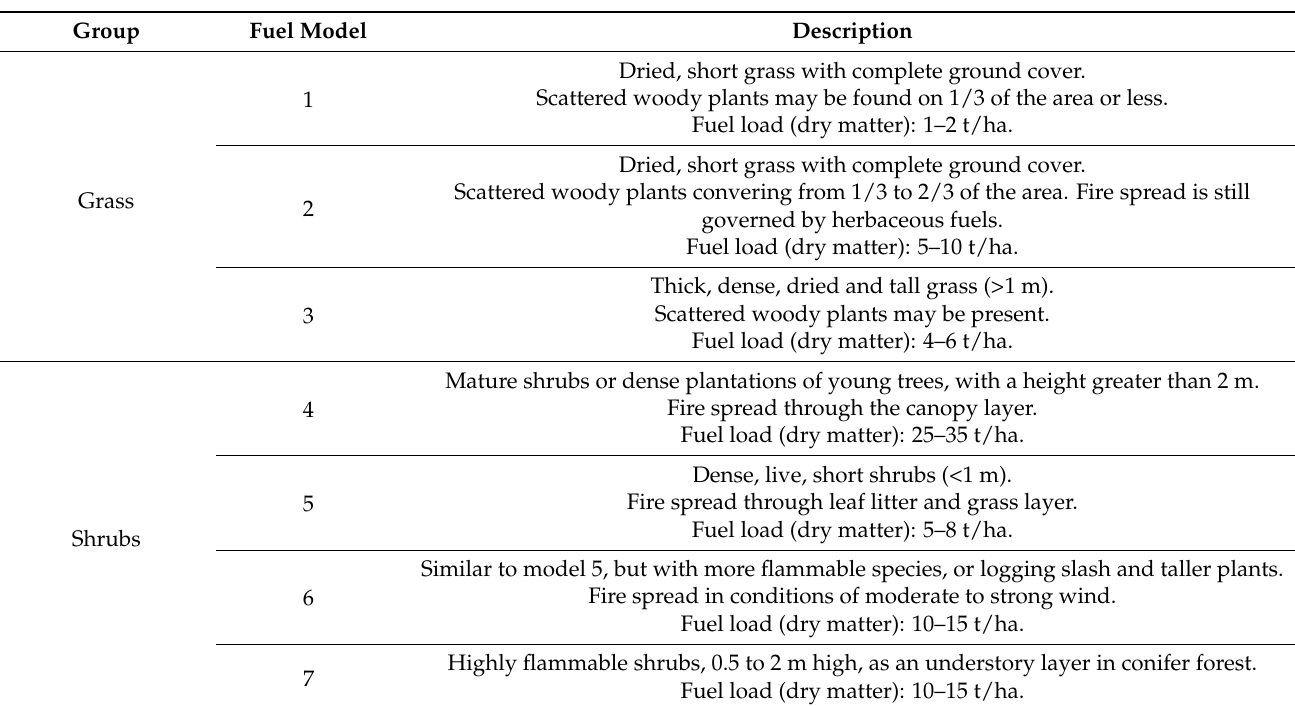
Table 3. Rothermel and Albini fuel models [109,110], as adapted in MFE25 [102]. Group Fuel Model Description